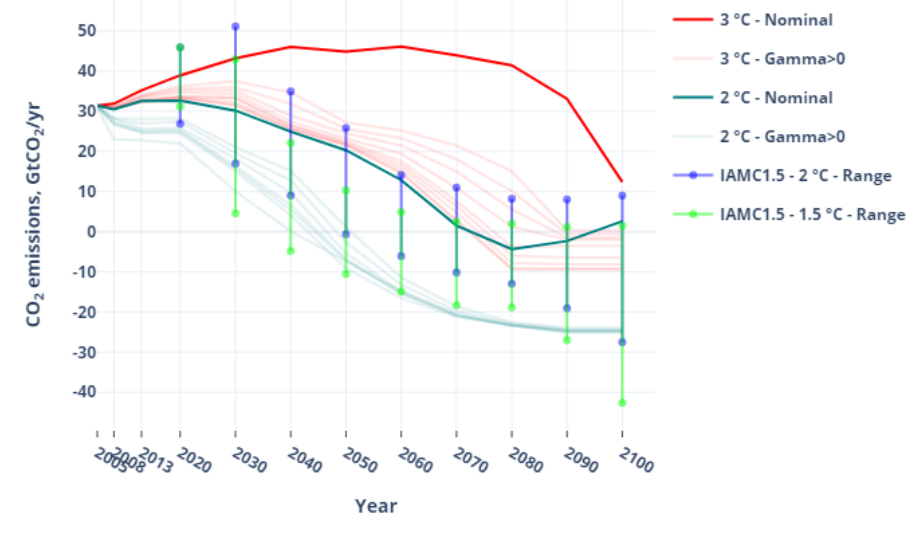
Figure 4. CO 2 emission profiles in the nominal and robust